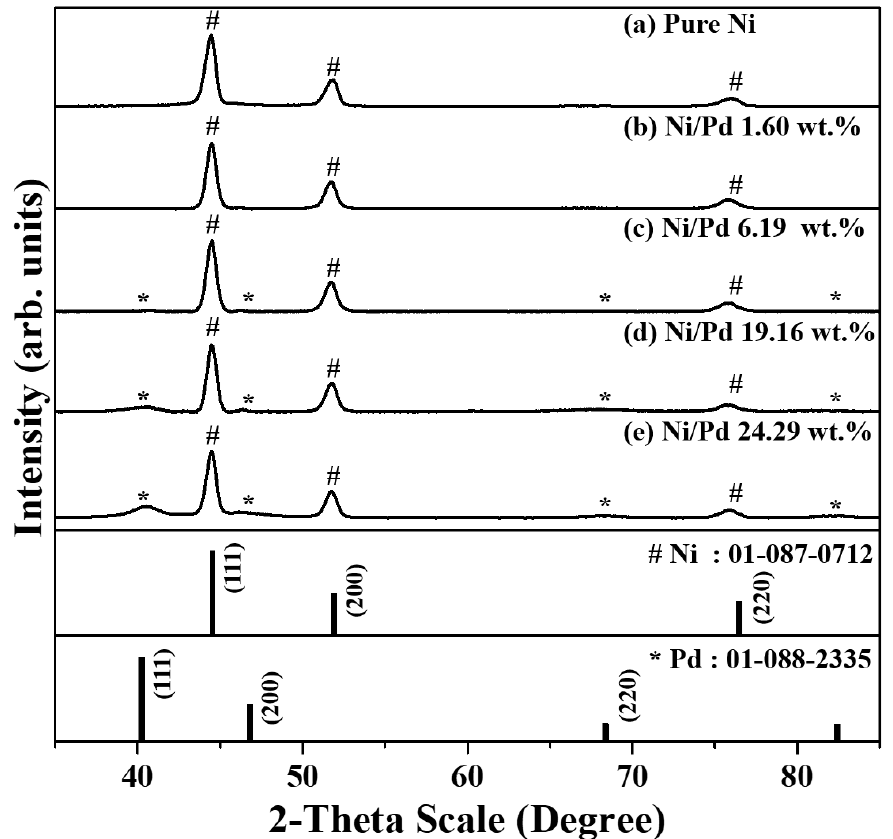
Figure 1. X-ray diffraction (XRD) patterns of ( a ) pure Ni and ( b – e ) Ni/Pd bimetallic nanoparticles (NPs) with different Pd loadings. The peaks marked by ‘#’ at 43.98°, 51.29°, and 75.58° are indexed to the (111), (200), and (220) planes of fcc structure Ni NPs (JCPDS #01-087-0712). The intensity peaks marked by ‘*’ at 40.06°, 46.16°, 68.29°, and 81.36° correspond to the (111), (200), and (220) planes of fcc Pd NPs (JCPDS #01-088-2335), respectively.